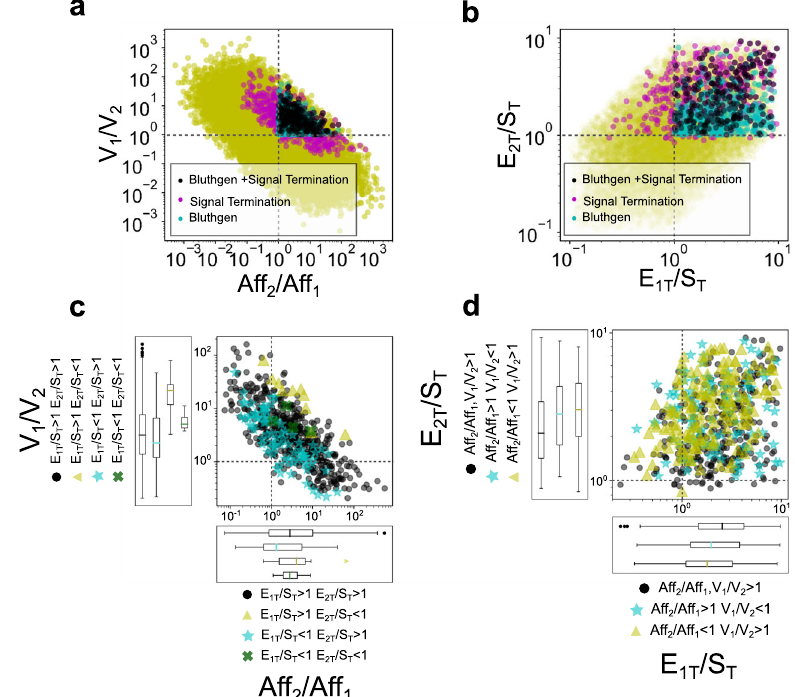
Fig. 3 Parameter space exploration. a V 1 / V 2 – Aff 2 / Aff 1 parameter space, b E 2T / S T – E 1T / S T parameter space. Both panels include the output of numerical simulations for 20,000 parameter sets in the selected ranges of variation. Each dot represents a single simulation output. Dots in purple correspond to outputs with signal termination, dots in cyan correspond to the parameter sets that satisfy Bluthgen ’ s conditions (see text), dots in black correspond to the parameter sets that satisfy Bluthgen ’ s conditions and signal termination. All the other simulation results are in yellow. Outputs lower than 0.1 were excluded from the analysis. Since E 1T and E 2T are not kept constant (as was the case in Fig. 2), V i = k i E 1T / K mi with i = 1,2. c V 1 / V 2 – Aff 2 / Aff 1 parameter space, but plotting only outputs with signal termination and magnifying the signal termination region. Each output is color and symbol coded according to the value of E 2T / S T and E 1T / S T , gray dots if E 2T / S T and E 1T / S T > 1, cyan stars if only E 2T / S T > 1, yellow triangles if only E 1T / S T > 1, green crosses if E 2T / S T and E 1T / S T < 1. d E 2T / S T − E 1T / S T parameter space, but plotting only outputs with signal termination and magnifying the signal termination region. Each output is color and symbol coded according to the value of V 1 / V 2 and Aff 2 / Aff 1 , gray dots if V 1 / V 2 and Aff 2 / Aff 1 > 1, cyan stars if only V 1 / V 2 > 1, yellow triangles if only Aff 2 / Aff 1 , green crosses if V 1 / V 2 and Aff 2 / Aff 1 < 1. Horizontal and vertical black lines over the plots indicate V 1 = V 2 , Aff 2 = Aff 1 , E 1T = S T , E 2T = S T , respectively. The characteristics of each distribution are captured in box plots giving the median (color line as central value), the 95% con fi dence interval of the median, the fi rst and third quartiles (box), the 5th, and 95th percentiles (end of whiskers). Extra symbols in line with the box plots are